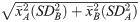
Quantitative analysis of molecular behaviour of Venus::BMAL1 measured by FCS.A, B), FCS of Venus::BMAL1 in unsynchronised MEFs (grey) and chondrocytes (blue). Representative autocorrelation curves were fitted to a one-component diffusion model with a triplet state. C, D) Quantitative analysis of Venus::BMAL1 FCS data. Scatter plots presented in pairs, first, as measurements of cells taken from an individual representative animal, followed by group data: mean averages across three different animals. Mean ±SD; n = 40 cells per mouse, from 3 mice. C) Diffusion coefficient (3.49 ±0.55 μm2/s in MEFs and 2.62 ±0.55 μm2/s in chondrocytes). D) Molecular concentration (17.5 ±2.47 nM in MEFs and 10.2 ±3.45 nM in chondrocytes). E) Mean ±SD nuclear volume measurements for MEF cells (grey, 306 ±95 fL, n = 30 cells) and chondrocytes (blue, 147 ±43 fL, n = 30 cells). F) Estimated number of Venus::BMAL1 molecules per nucleus in MEFs and chondrocytes. The calculation of the mean was based on the molecular concentration of Venus::BMAL1 in each cell and the average nuclear volume for that cell type, as calculated in E. In the group data (right), the SD was adjusted by using a formula: x¯A2(SDB2)+x¯B2(SDA2) to correct for the propagation or error. Statistics: Nuclear volumes: Unpaired two- tailed t-test; concentration, diffusion coefficient and molecular number: Paired two-tailed t-test.